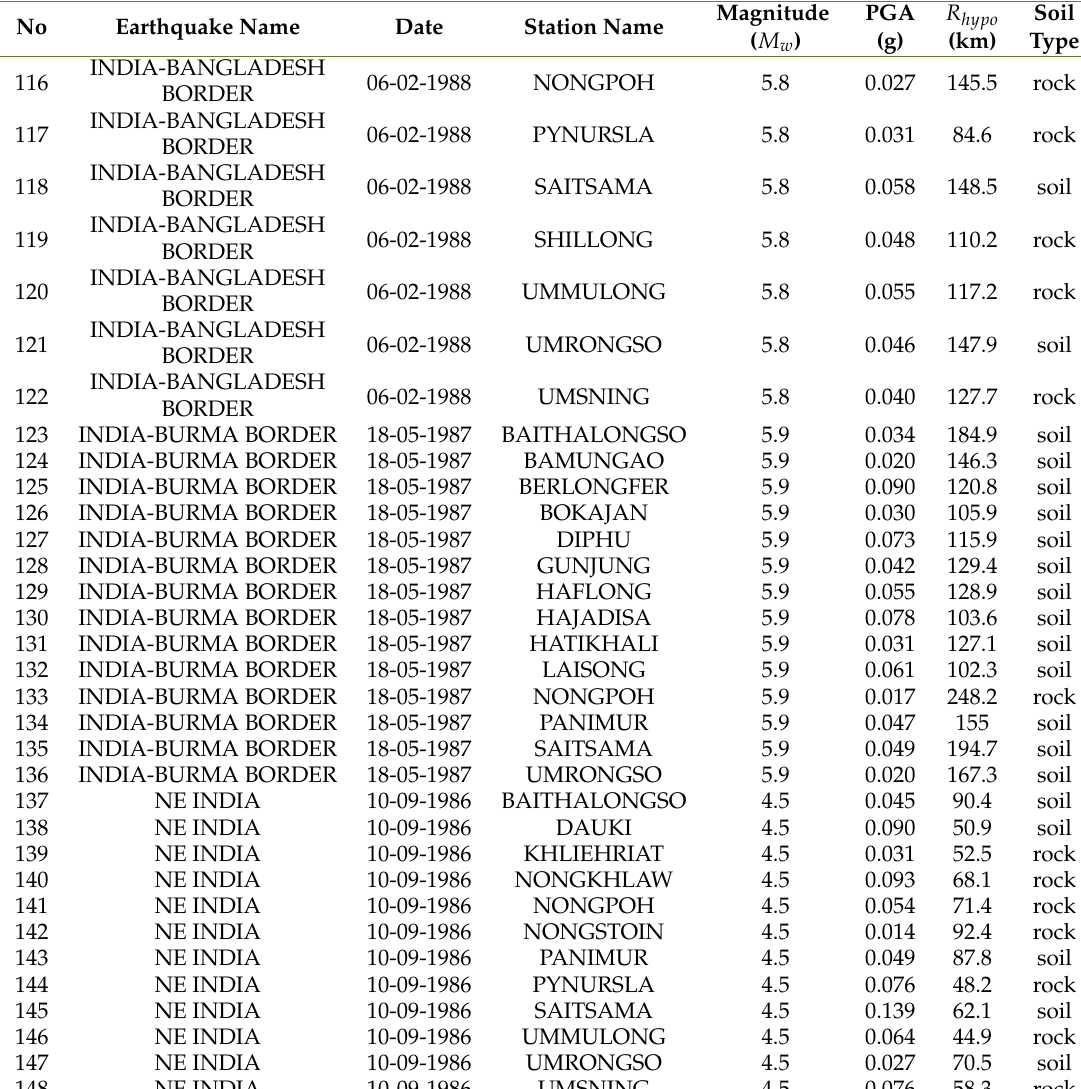
Table A1. Ground motions used in this study